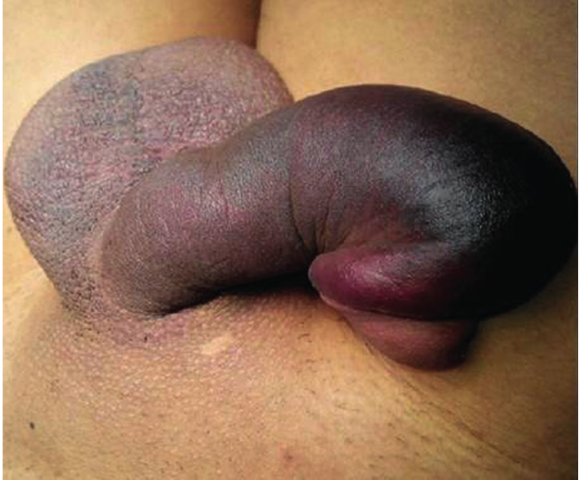
Figure 1 - Twenty-eight year-old man with penile fracture. clinical photograph showed a markedly swollen, purple and painful penis resembling an eggplant.